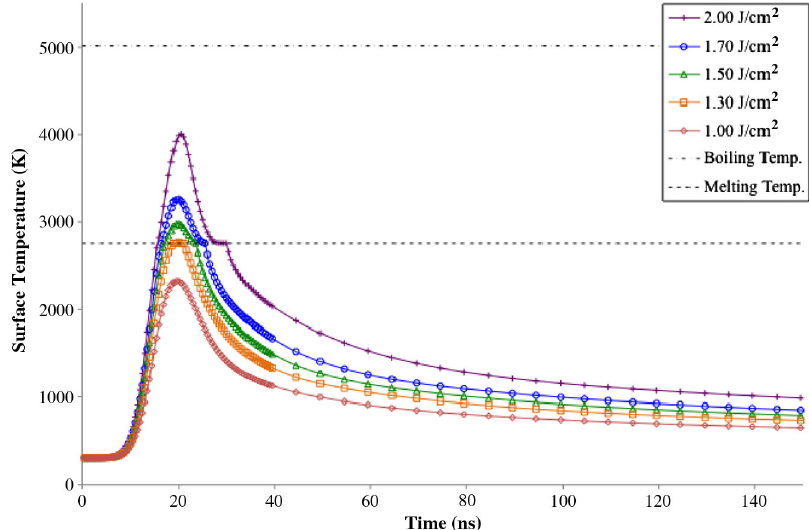
FIG. 1. The simulated surface temperature for Nb due to the absorption of a 8 ns 1064 nm laser pulse for varying fluence values. The melting and boiling temperature are shown as dashed and dot-dashed lines